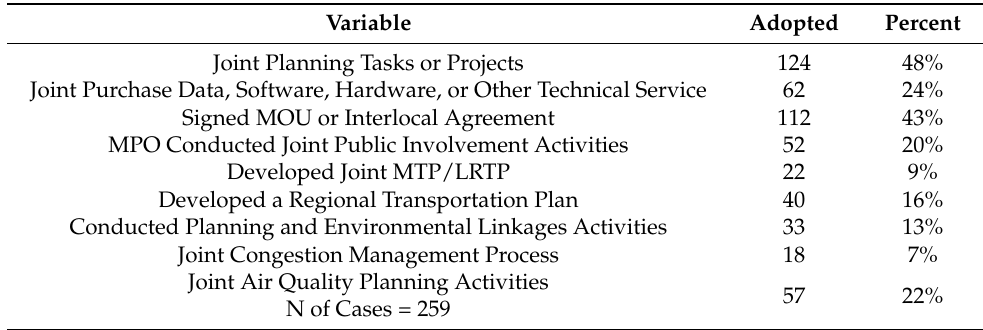
Table 1. MPO use of specific collaboration mechanism.